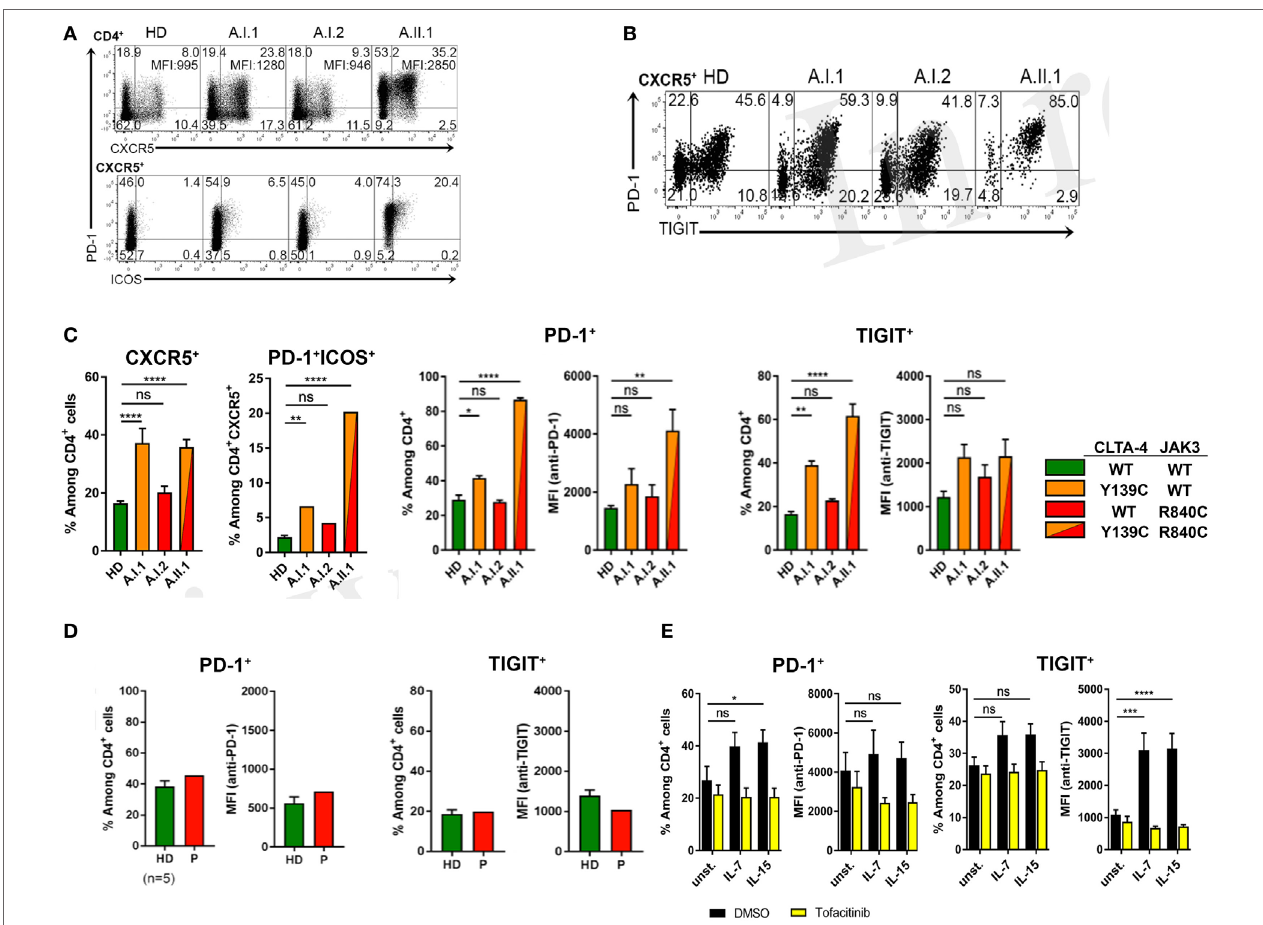
FigUre 5 | PD-1 and TIGIT expression by T FH cells. (a) PD-1, CXCR5, and ICOS expression shown by representative flow cytometry plots of PBMCs gated on CD3 + CD4 + from a healthy donor (HD) and members A.I.1, A.I.2, and A.II.1 (patient) of family A. Numbers in quadrant corners show population frequencies, additional numbers in upper right corner (top) represent mean fluorescence intensity (MFI) of PD-1 expressed by CXCR5 + PD-1 + cells. (b) Flow cytometry plots of PBMCs showing PD-1 and TIGIT expression by CXCR5 + CD4 + T cells. (c) Left panels: frequency of PD-1 and TIGIT expressing CXCR5 + and ICOS + CD4 + T cells of HD (green), A.I.1 (orange), A.I.2 (red), and A.II.1 (red/orange). Middle panels: frequency of PD-1 + and of TIGIT + CD4 + T cells and mean fluorescence intensity (MFI) of PD-1 and TIGIT expressed by CD4 + T cells of HD, A.I.1, A.I.2, and A.II.1 (D) PD-1 and TIGIT expression by an unrelated cytotoxic T lymphocyte antigen-4 (CTLA-4) haploinsufficiency patient with a heterozygous p.Y89X CTLA-4 mutation. (e) Frequency of PD-1 and TIGIT expressing CD4 + cells and expression levels of PD-1 and TIGIT determined by the MFI of PD-1 and TIGT expressed by CD4 + T cells treated for 5 days with or without (unst.) IL-7 and IL-15 in the presence or absence of the JAK inhibitor tofacitinib. Data in (c) represent mean ± SEM of 26 different donors (HD, CXCR5 + , and PD-1 + ICOS + ) and two family visits, or mean ± SEM of 4 (TIGIT) and 7 (PD-1) different HDs and 2 (TIGIT) and 3 (PD-1) family visits, in (D) the mean ± SEM of five different HDs and the CTLA-4 p.Y89X patient, and in (e) show the mean ± SEM of three experiments with six different HDs. **** P ≤ 0.0001; *** P < 0.001; ** P < 0.01; * P ≤ 0.05. One-way ( a , c ) or two-way (D) ANOVA, Dunnett’s multiple comparisons